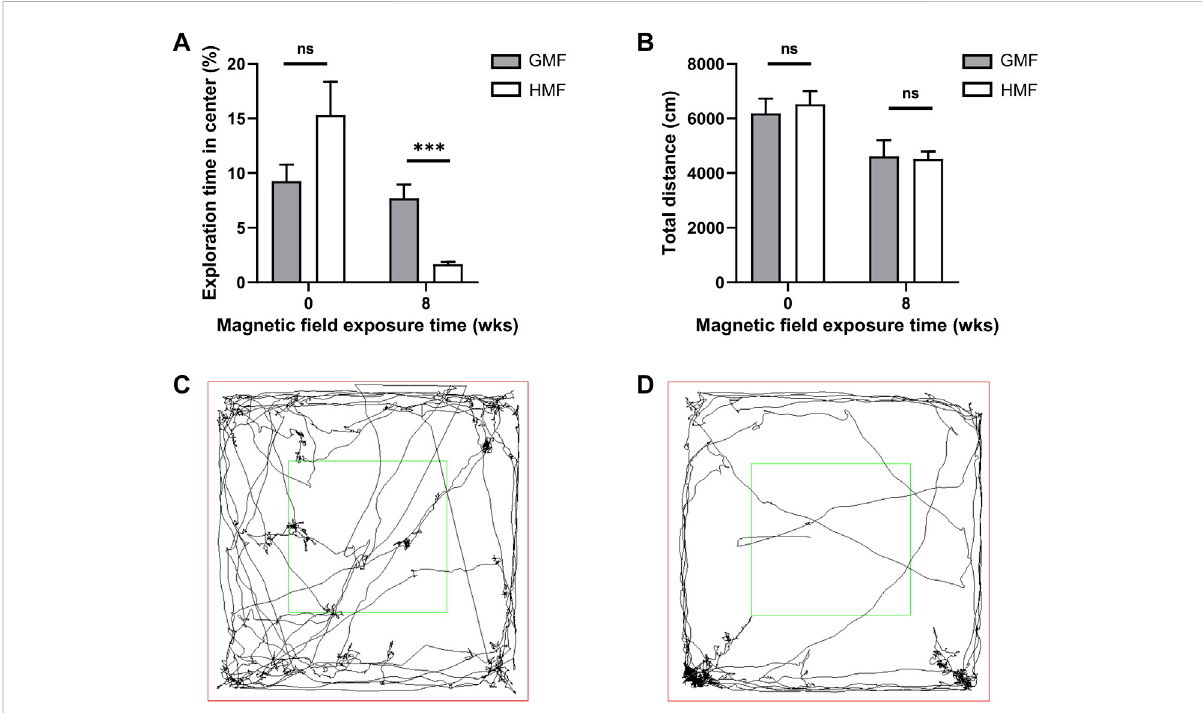
FIGURE 7 Exposure to the hypomagnetic fi eld (HMF) inducedanxiety-like behaviors inmice. (A) Comparison of theproportions of theexploration time in the central area of the open fi eld maze to the total exploration time in mice exposed to different magnetic fi elds ( P 8w = 0.0002). (B) Comparison of totaltraveldistancesofmiceexposedtodifferentmagnetic fi eldsintheopen fi eldmaze. (C) Therepresentativeimageofthetrajectoryofmiceinthe open fi eld maze after 8-week GMF exposure. (D) The representative image of the trajectory of mice in the open fi eld maze after 8-week HMF exposure. There were 10 mice in each group at each time point. ns, no signi fi cance. Data are expressed as mean ± SEM. *** p < 0.001. GMF means geomagnetic fi eld; wks means weeks.